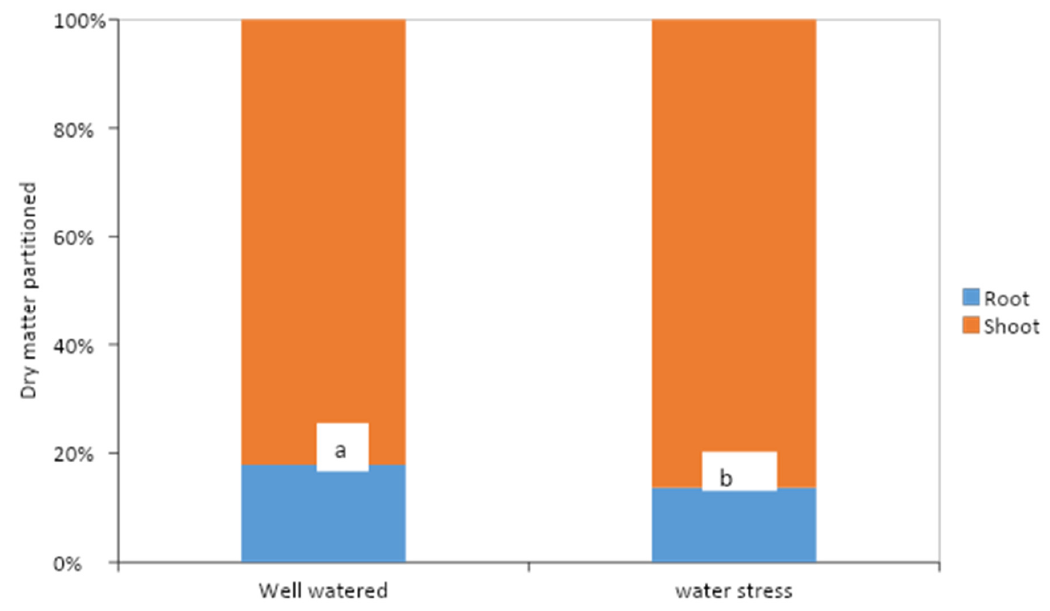
Figure 6. Relative dry matter partitioned into roots and shoots of cocoa seedlings after subjecting four month old cocoa seedlings to 55 days of water stress or well-watered conditions in a gauzehouse facility. Data from experiment 1; different letters (a and b) indicate significant differences at p = 0.05.